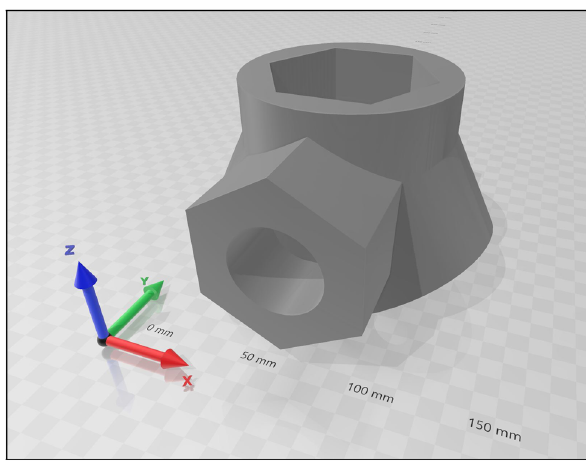
Figure 9: The joint designed for case